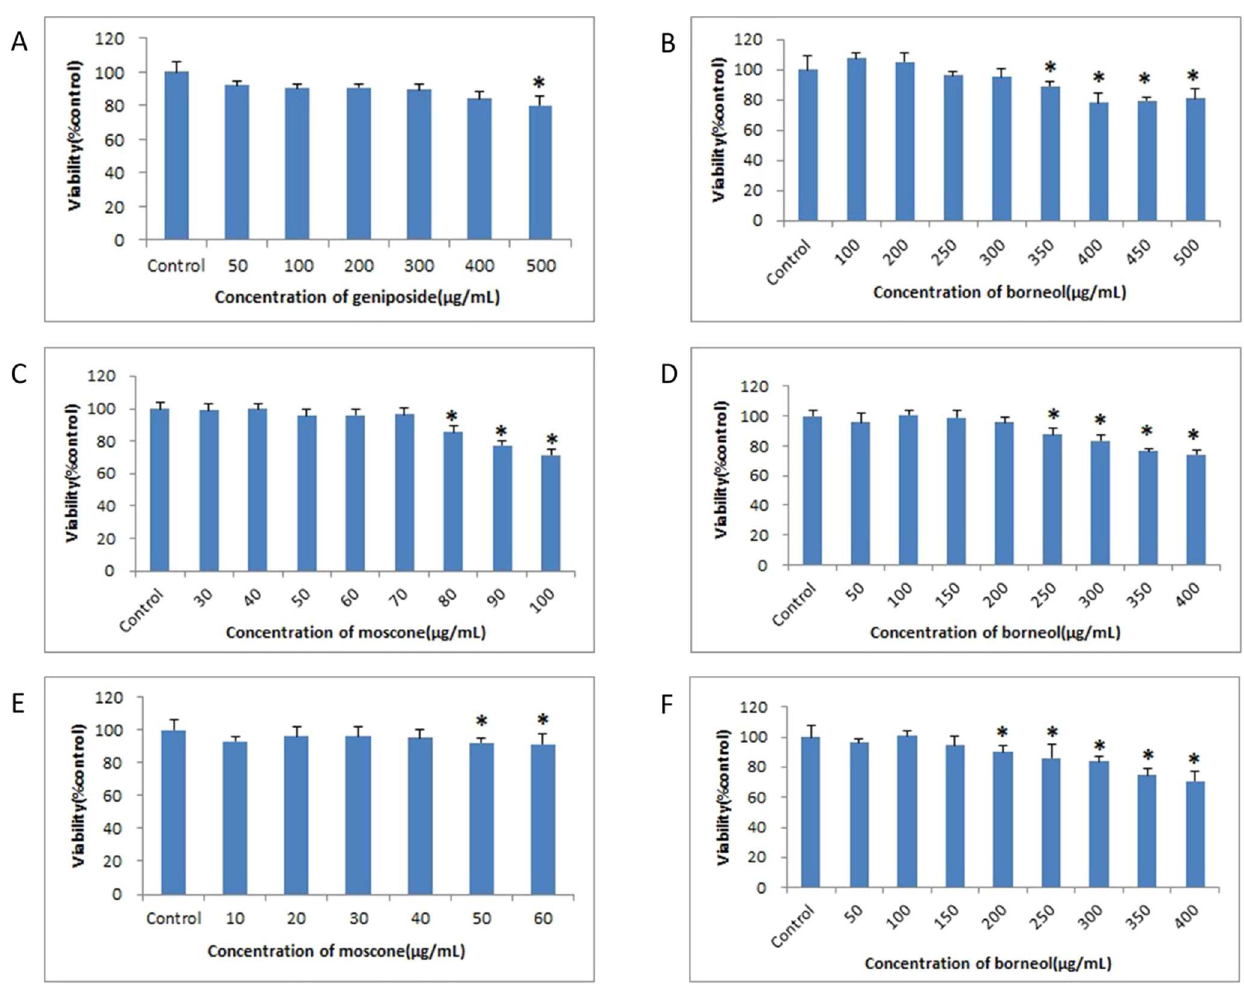
Figure 1. Cytotoxicity of geniposide, borneol, muscone and their combinations determined by MTT test. (A) Geniposide has no cell cytotoxicity in the concentration range of 0–400 m g ? mL 2 1 . (B) Borneol has no cell cytotoxicity in the concentration range of 0–300 m g ? mL 2 1 . (C) Muscone has no cell cytotoxicity in the concentration range of 0–70 m g ? mL 2 1 . (D) GB group (geniposide:borneol, 0.9:1, w/w) has no cell cytotoxicity in the concentration range of 0–200 m g ? mL 2 1 calculated by borneol. (E) GM group (geniposide:muscone, 6:1, w/w) has no cell cytotoxicity in the concentration range of 0–40 m g ? mL 2 1 calculated by muscone. (F) GBM group (geniposide:borneol:muscone, 0.9:1:0.15, w/w/w) has no cell cytotoxicity in the concentration range of 0–150 m g ? mL 2 1 calculated by borneol. Date are expressed as mean 6 SD ( n =5). * P , 0.05 compared with the control group.